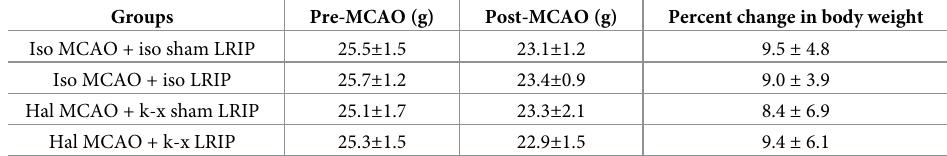
Table 1. Changes in body weight across groups.